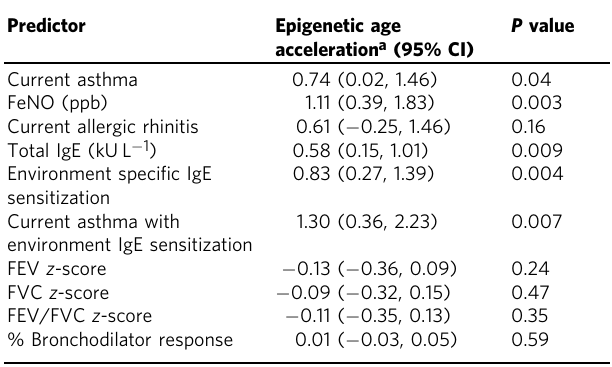
Table 6 Association of epigenetic age acceleration with asthma, allergy, and lung function